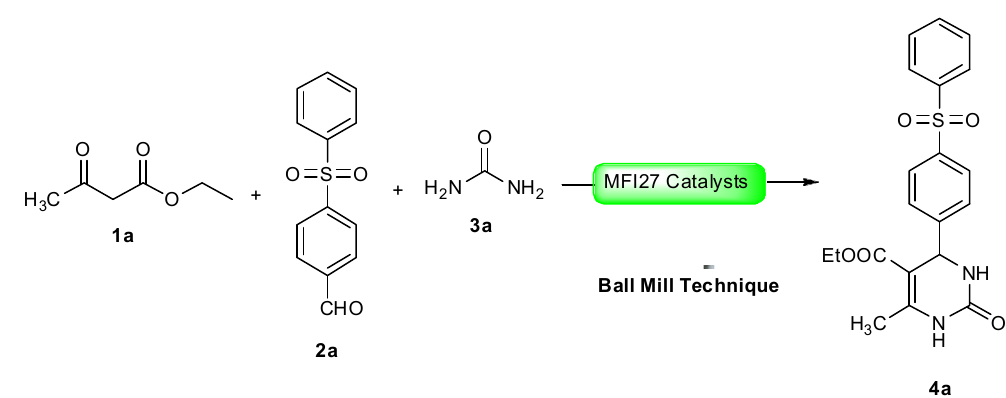
Scheme 1. Optimization of the reaction conditions for the three component reaction.